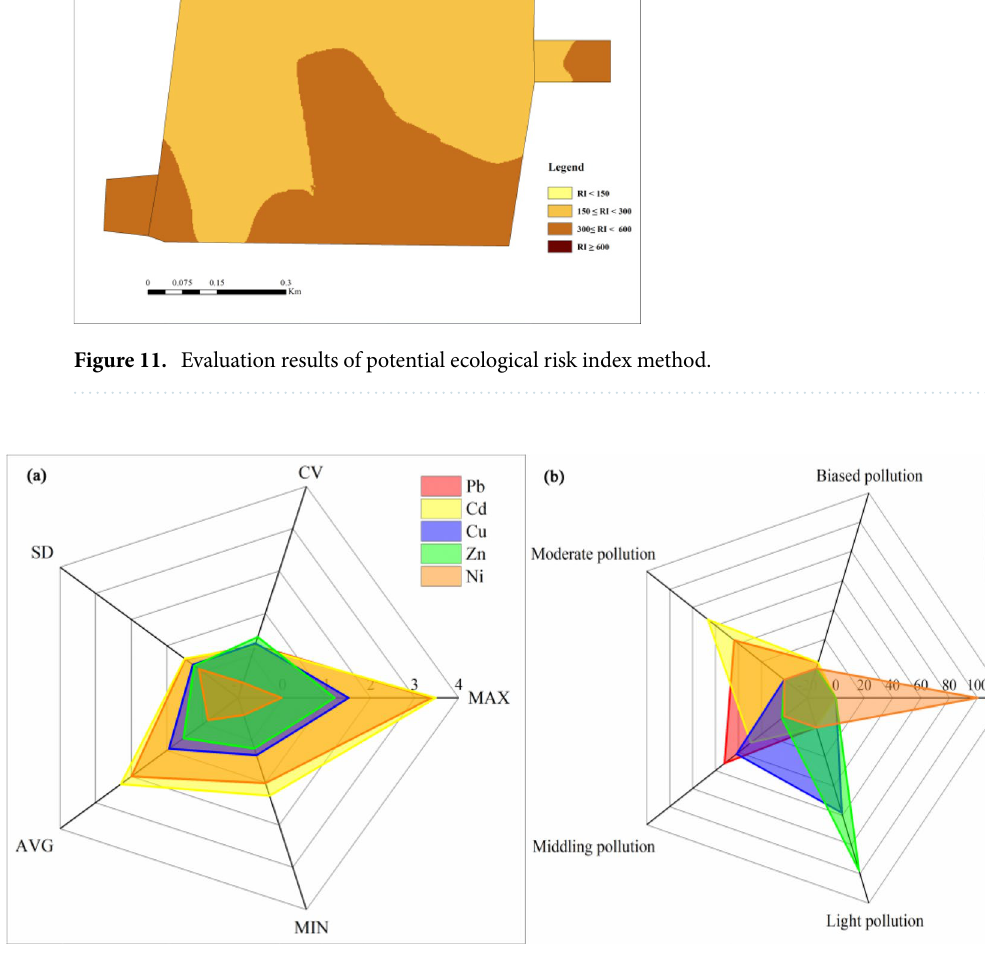
Figure 12. Statistical analysis of heavy metal geoaccumulation index in soil. ( a ) The geoaccumulation index of five heavy metals. ( b ) Evaluation results of the geoaccumulation index of five heavy